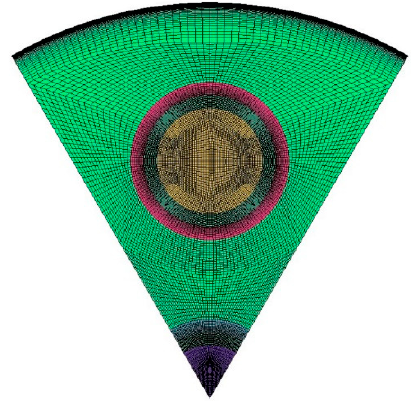
Figure 4. Mesh front view.